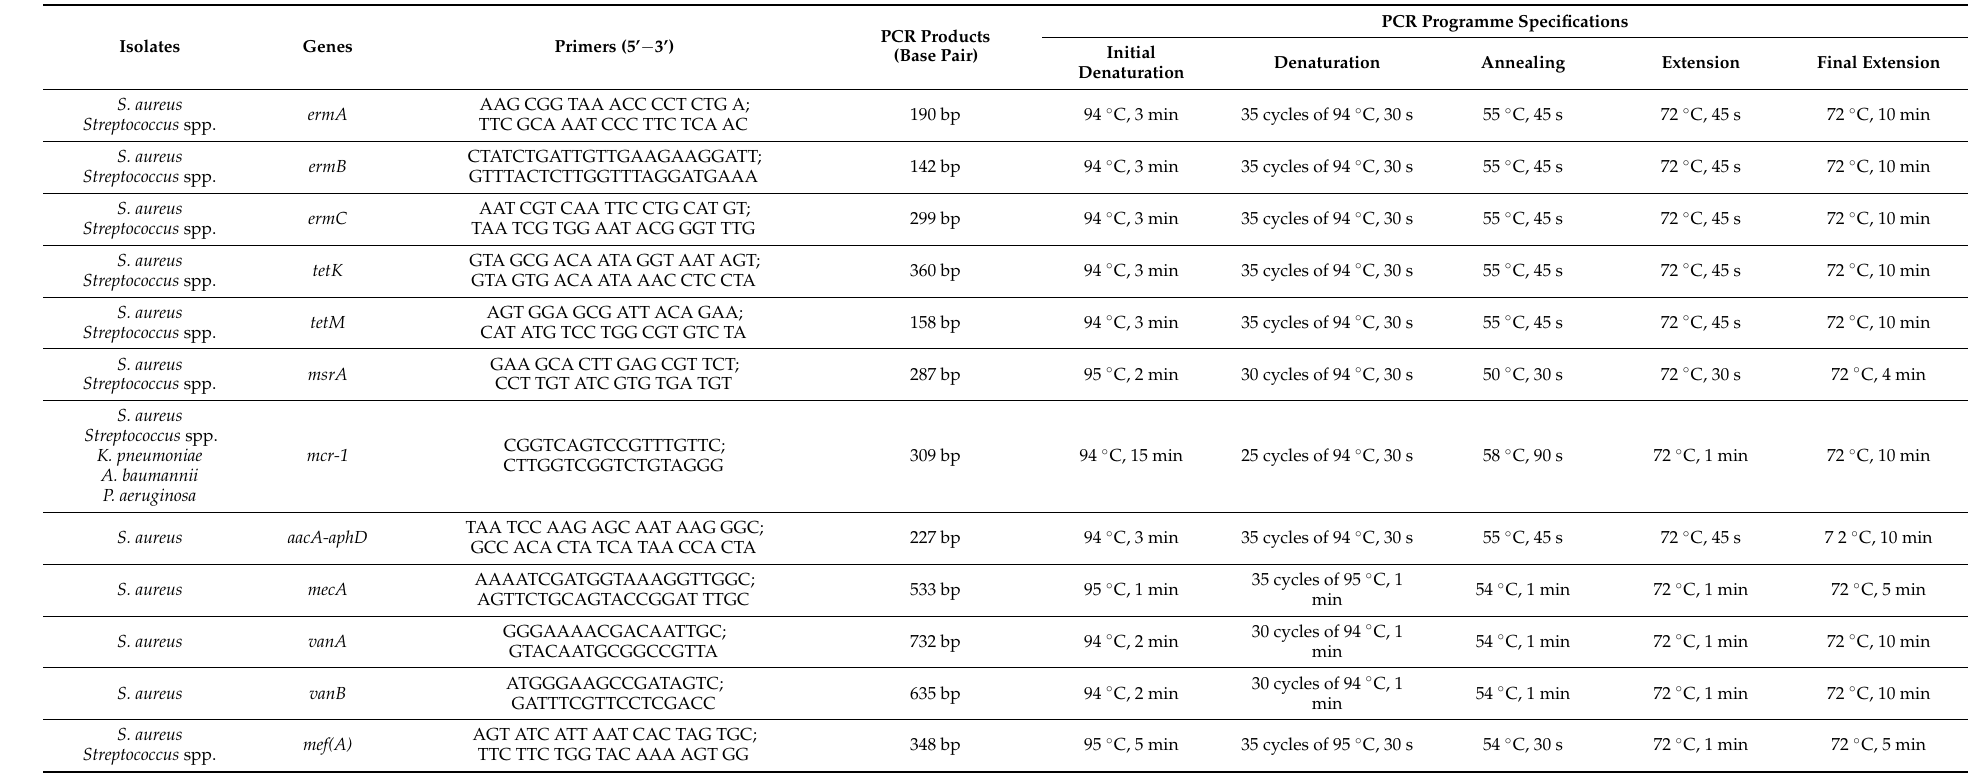
Table 1. PCR primers and programme specifications for the targeted genes in the respective bacteria